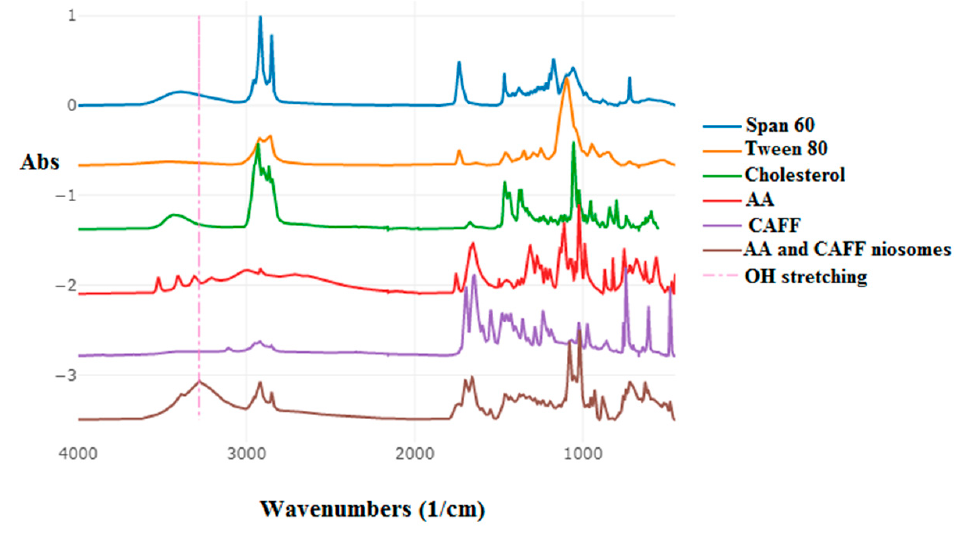
Figure 4. The FTIR spectrum of AA and CAFF niosome, Tween 80, (Span 60, and AA, CAFF and